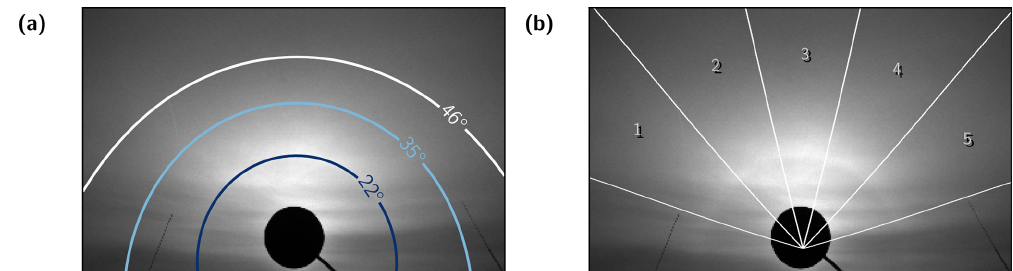
Figure 3. (a) HaloCam RAW image (red channel) from 2 February 2016, 09:42UTC, with corresponding scattering angle ( ϑ ) grid and representative contour lines at 22, 35, and 46 ◦ . (b) Relative azimuth angle ( ϕ ) grid with numbered labels for the five image segments, each spanning an interval of 30 ◦